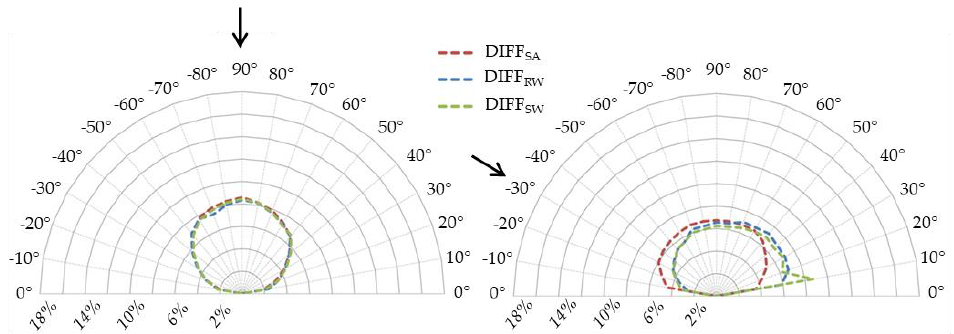
Figure 5. Angular reflectivity profiles of diffusive samples: DIFF SA (red dotted line), DIFF RW (blue dotted line), and DIFF SW (green dotted line), for a 90° and −30° angle of incident radiation. Table 3. Retro-reflectivity of the three RR samples, for each angle of incident radiation. Percentage values are referred to the ratio between the radiation reflected back to the source and the total reflected radiation for each sample. The RR sample with the maximum retro-reflective percentage is highlighted in bold for each angle of incidence.